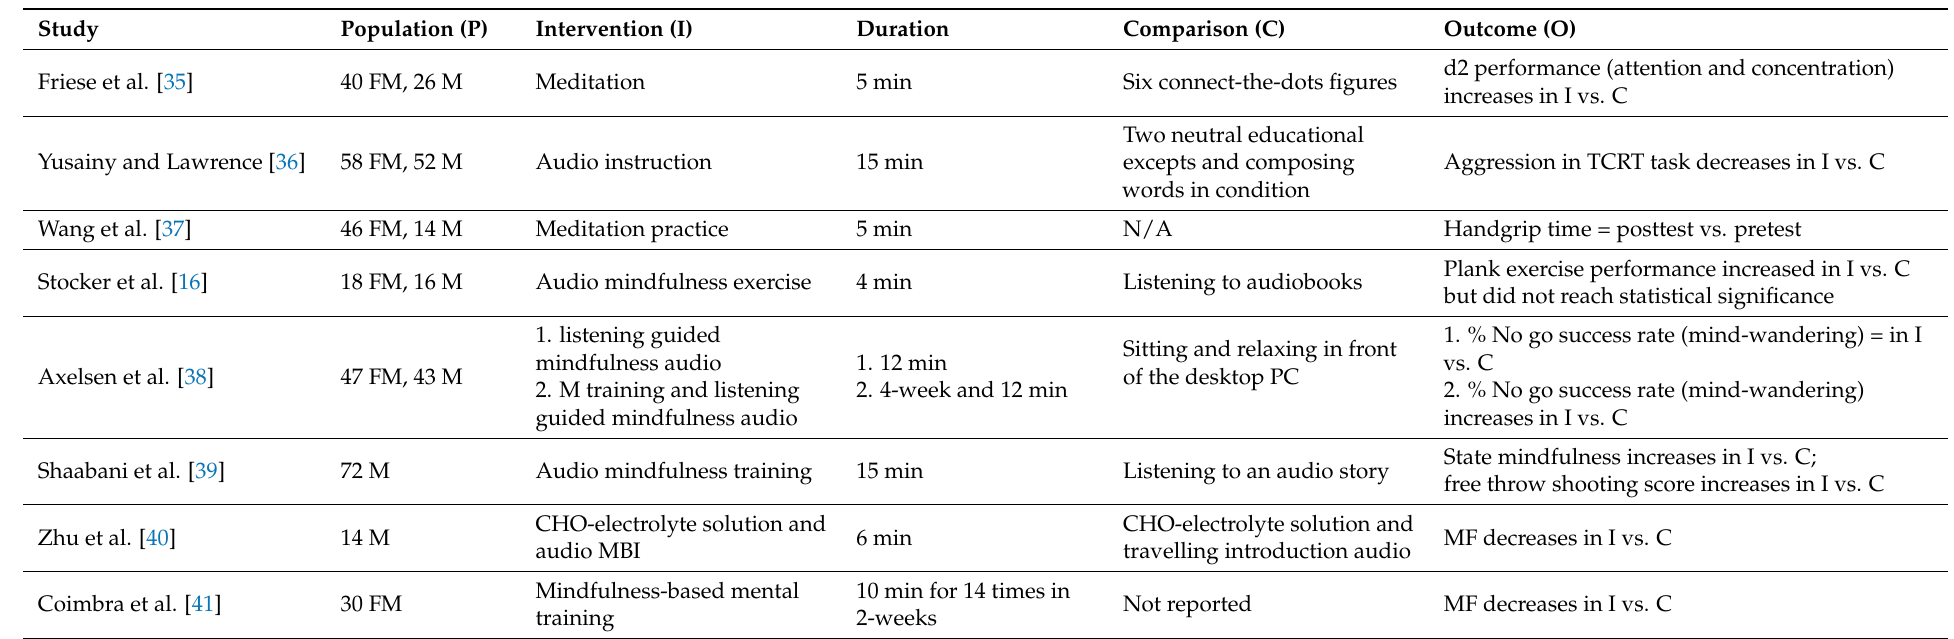
Table 5. Overview of mindfulness-based